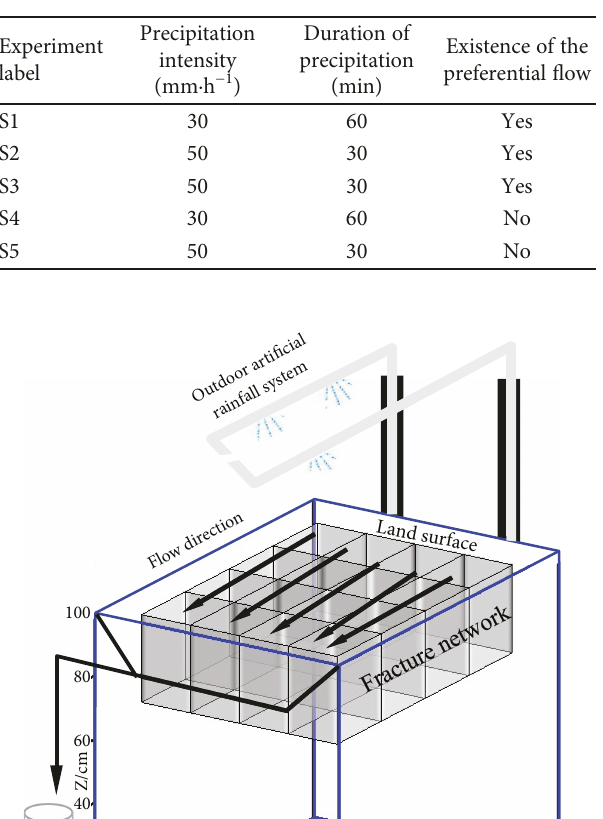
Table 2: Experimental conditions of the plots.